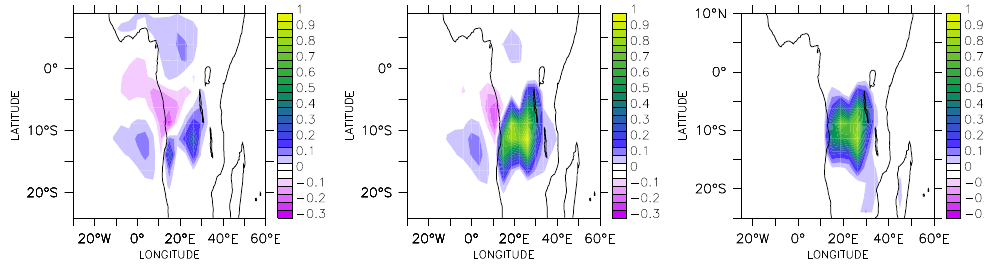
Fig. 14. Daily Tropospheric Excess of CO 2 (ppmv) in July as simulated by simulations REF (left) and TH (middle) and estimated from CO 2 emissions by assuming a uniform distribution of CO 2 emissions between 800 and 500 hPa (right).